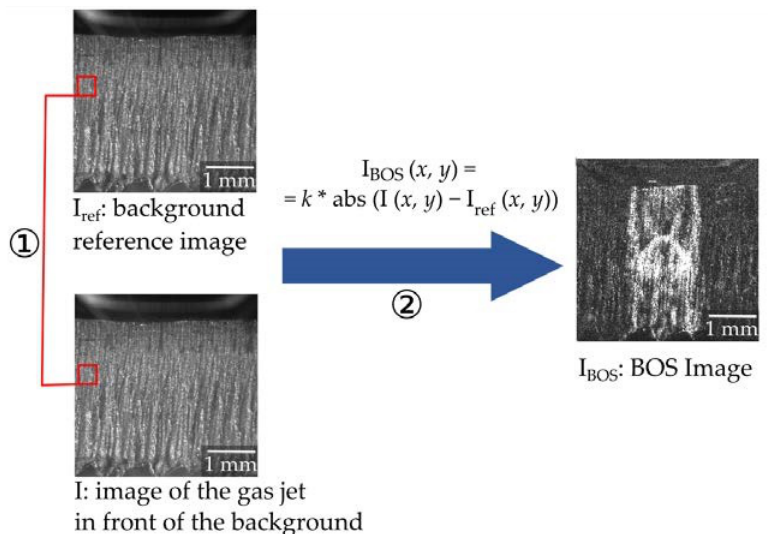
Figure 3. Image processing steps for BOS: (1) preprocessing (optional, depending on the imaging situation): exact alignment and brightness adjustment. (2) Comparison between I and I ref results in the BOS image I BOS .